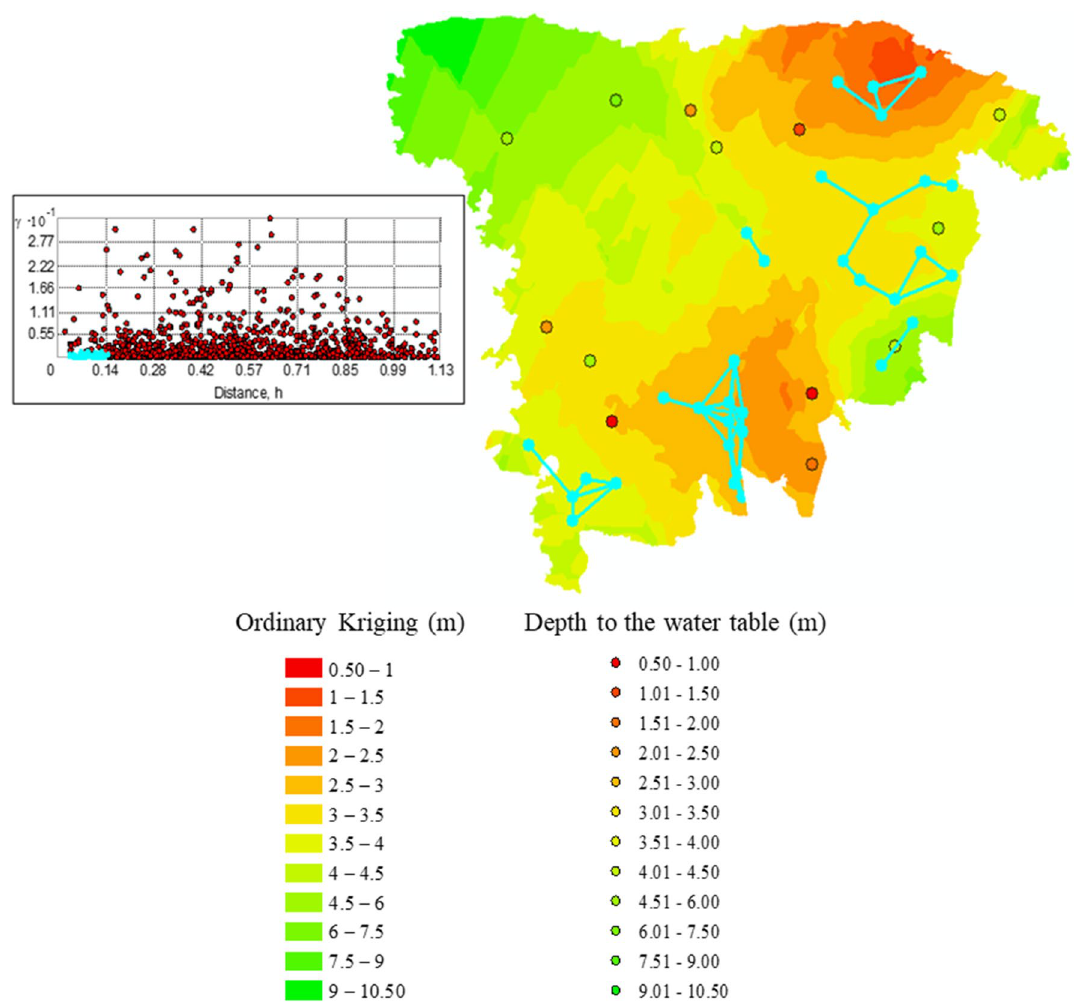
Fig. 3 Directional influence for the groundwater level of